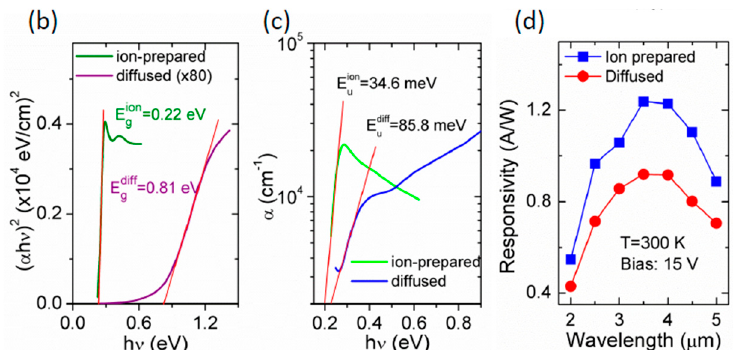
Figure 13. Preparations and characterizations of PbSe polycrystalline coatings prepared by oxygen ion beam implantation: ( a ) morphological and structural; ( b ) Tauc’s plot; ( c ) Urbach tail; and ( d ) responsivity spectra with a comparison with the diffused one. Reprinted with permission from [100]. Copyright Elsevier 2017.